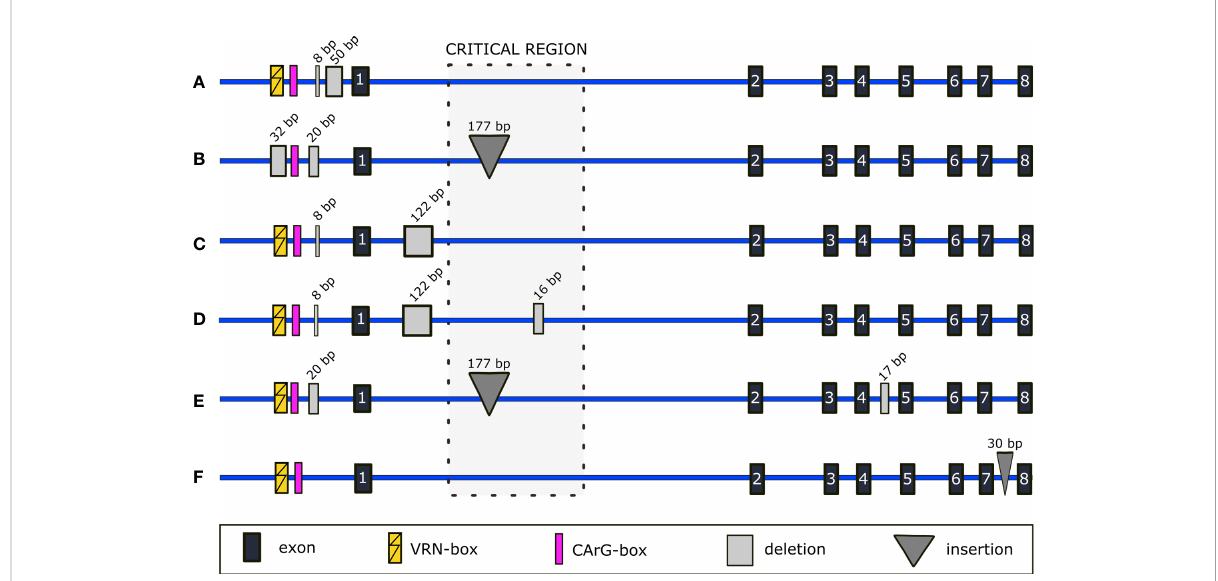
FIGURE 2 Schematic representation of selected indels detected within non-coding regions of VRN-A1 . Promoter mutations in (A) correspond to known mutations of Vrn-A1f and Vrn-A1f-like alleles, but no intronic mutations are present. Mutations in (B) correspond to the Vrn-A1d allele with revealed 177-bp insertion in intron 1. Newly detected intron 1 deletion is shown in (C) . In (D) , known mutations of the VRN-A1b allele and novel 17-bp deletion of intron 4 are depicted. A novel deletion in intron 7 is represented in (E) . An insertion of 30 bp situated in intron 7 is shown in (F)